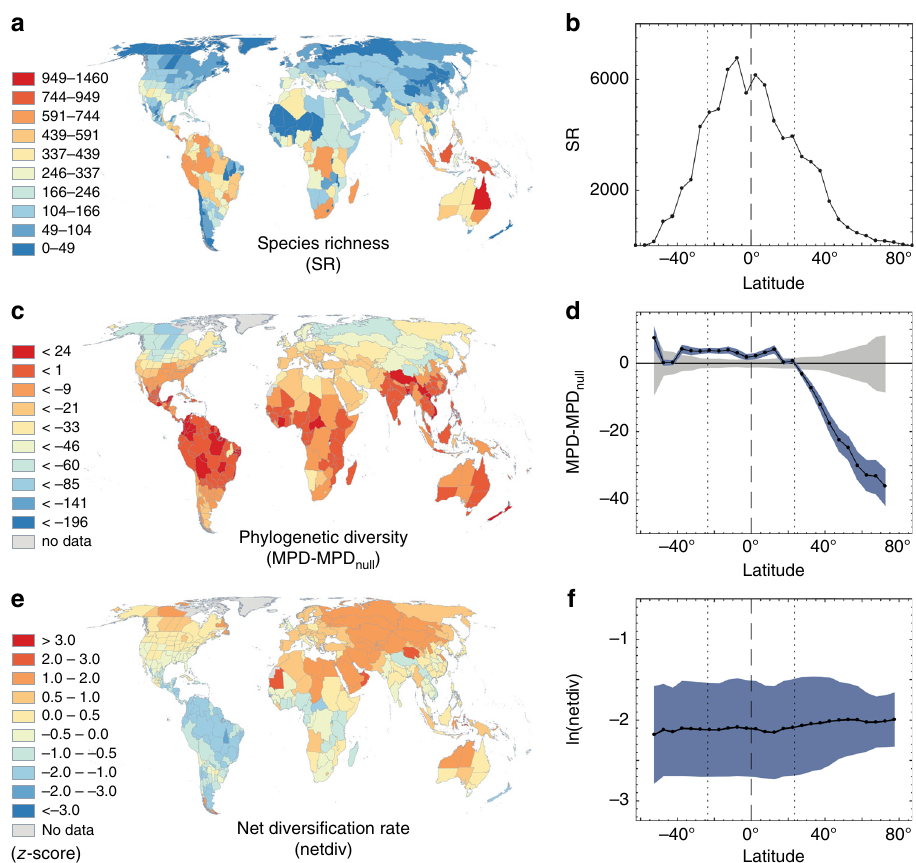
Fig. 2 Global patterns of ant diversity and evolution. Species richness by a region and b 5° latitudinal band. Phylogenetic diversity by c region and d latitudinal band, where the gray area re fl ects the distribution of 95% null values while the blue area re fl ects 95% of observed values across 100 trees in the posterior distribution. Both null and observed values were subtracted from the null mean for each tree. Mean of ln(median diversi fi cation rate across trees) for all species in each e region or f latitudinal band, with blue shading standard deviation of the variation within each band. These plots are based on trees constructed with NC-stem dating/grafting method, but corresponding results with other methods are found in Supplementary Figs.